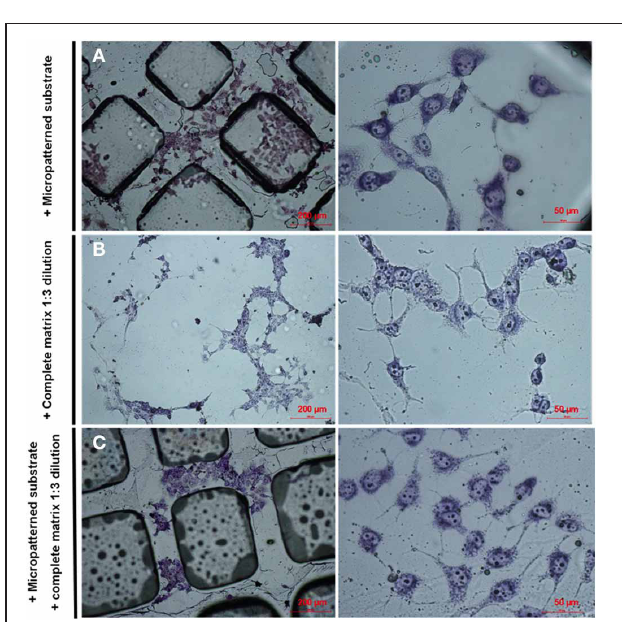
FIGURE A1 | Effects of micropatterned substrate and neural ECM on PC12 cell differentiation in the absence of NGF. PC12 cells were stained with May Grunwald’s eosin methylene blue solution modified for microscope staining after 7 day-differentiation in vitro . (A) Cells differentiated in the presence of micropatterned substrate only. (B) Cells differentiated in the presence of ECM only. (C) Cells differentiated in the presence of both micropatterned substrate and